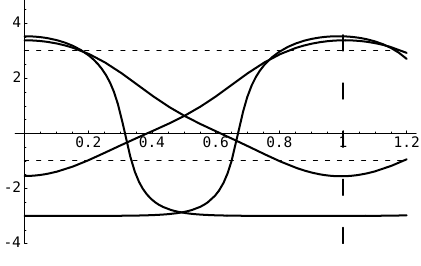
Figure 10. Solutions of problem (5.2) in neighbourhoods of the p 2 and p 4